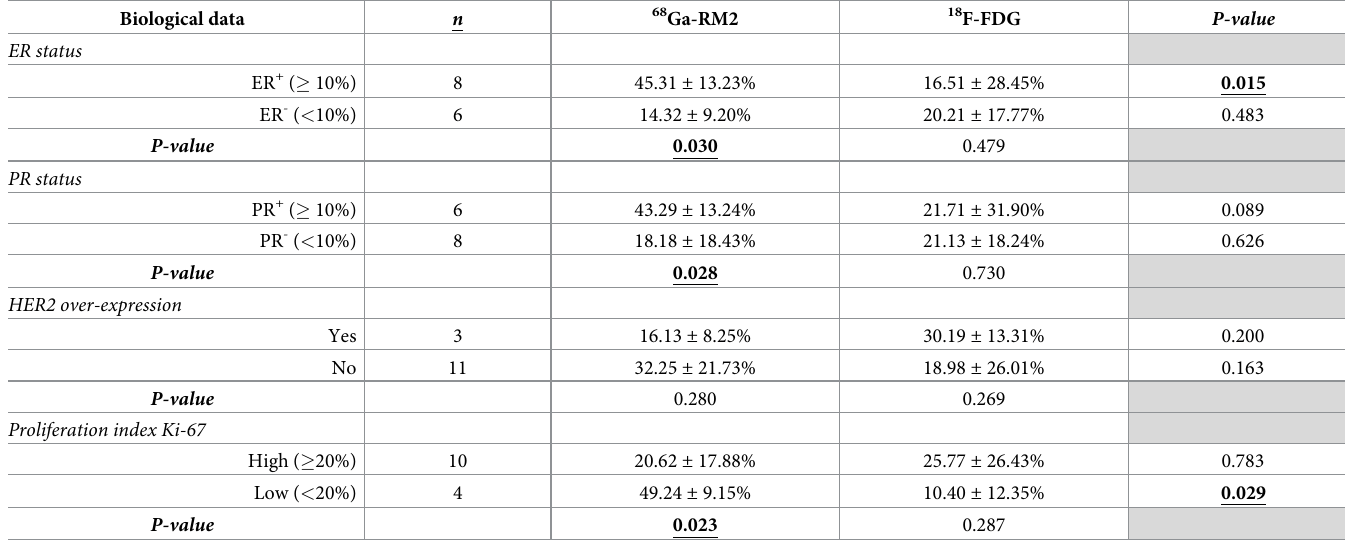
Table 3. 68 Ga-RM2 and 18 F-FDG bindings in breast cancer samples according to biological data. Biological